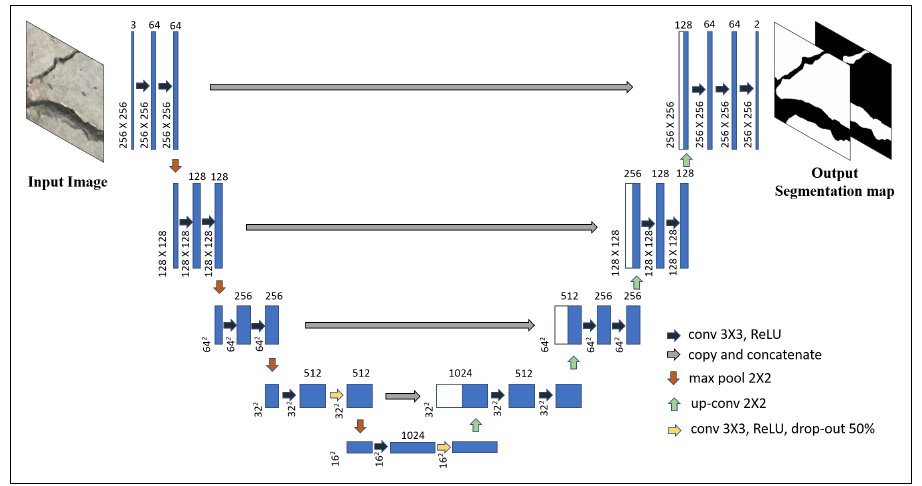
Figure 2. Deep Convolution Neural Network architecture, U-Net, with sample RGB input image and output segmentation maps which denotes probability of crack and non-crack